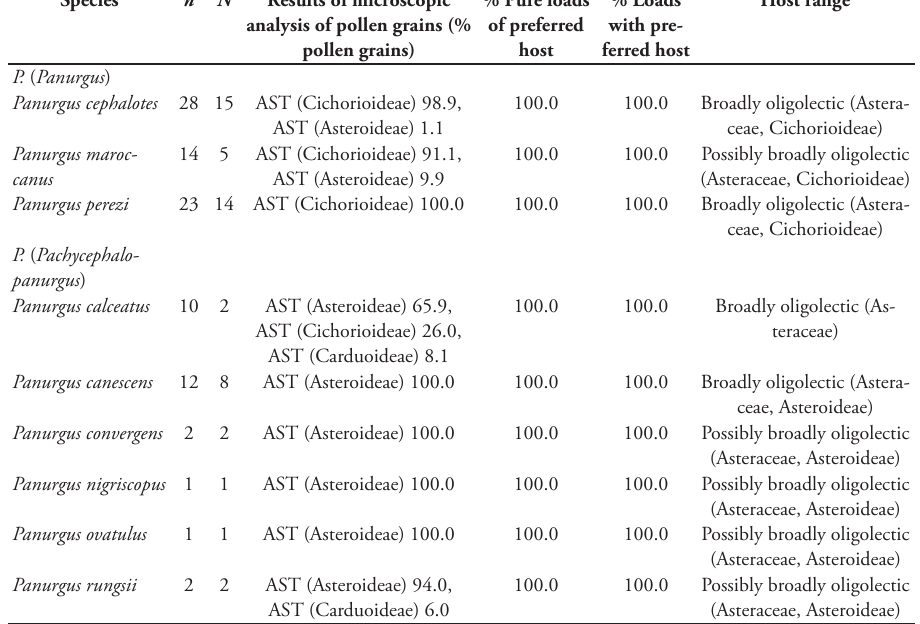
Table 3. Host plant spectrum and inferred category of host use in Panurgus species. n total number of pollen loads, N number of pollen loads from different localities. Plant taxa AST, Asteraceae. Species n N Results of microscopic % Pure loads % Loads Host analysis of pollen grains (% of preferred with pre- pollen grains) host ferred host